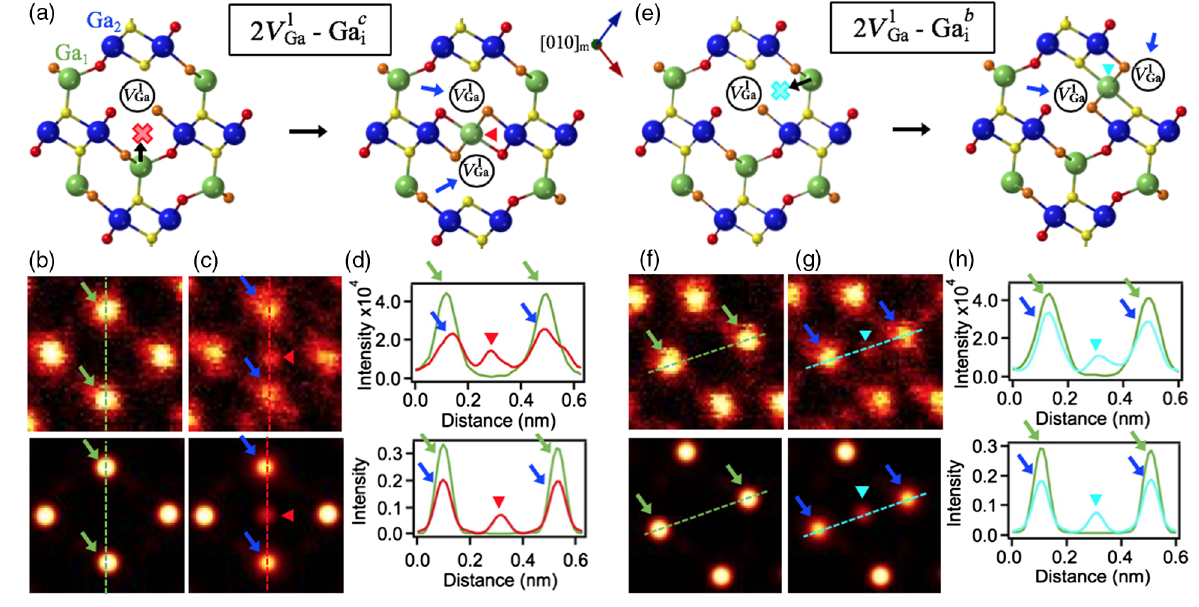
− Ga V 1 FIG. 3. Migration mechanism of V 1 for the formation of 2 V 1 , an adjacent Ga 1 relaxes i complexes. In the presence of a Ga Ga Ga into the (a) i c or the (e) i b site, creating an additional V 1 . (b) – (d) Experimental and simulated HAADF images showing multiple Ga 2 V 1 − Ga c ½ 010 (cid:2) m direction. (d) Line profiles from a [(b), green-dashed] defect-free and [(c), red-dashed] i complexes along the Ga interstitial containing experimental images show a significant reduction in Ga 1 intensity (blue arrows) from vacancies when neighboring i c interstitials (red triangle) are compared to unperturbed Ga 1 columns (green arrows). (d) Line profiles from a [(b), green-dashed] simulated defect-free and a [(c), red-dashed] simulated 25-nm ( ∼ 82 atoms) thick crystal containing 10 defect complexes located near the surface, showing similar profiles to the corresponding experimental images. (f) – (h) Similarly, experimental and simulated HAADF − Ga b images show multiple 2 V 1 i complexes along the depth direction. The simulated crystal contains 10 defect complexes located Ga near the